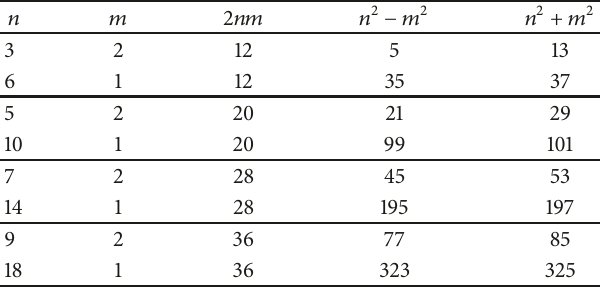
Table 1: Pairs of primitive Pythagorean triples with identical leg,